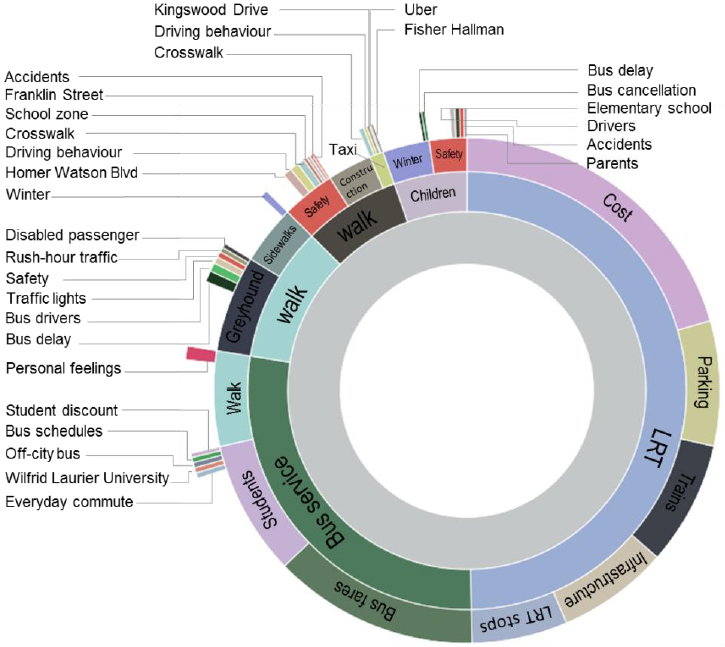
Figure 12. An overview of topic hierarchy generated from citizen letters.